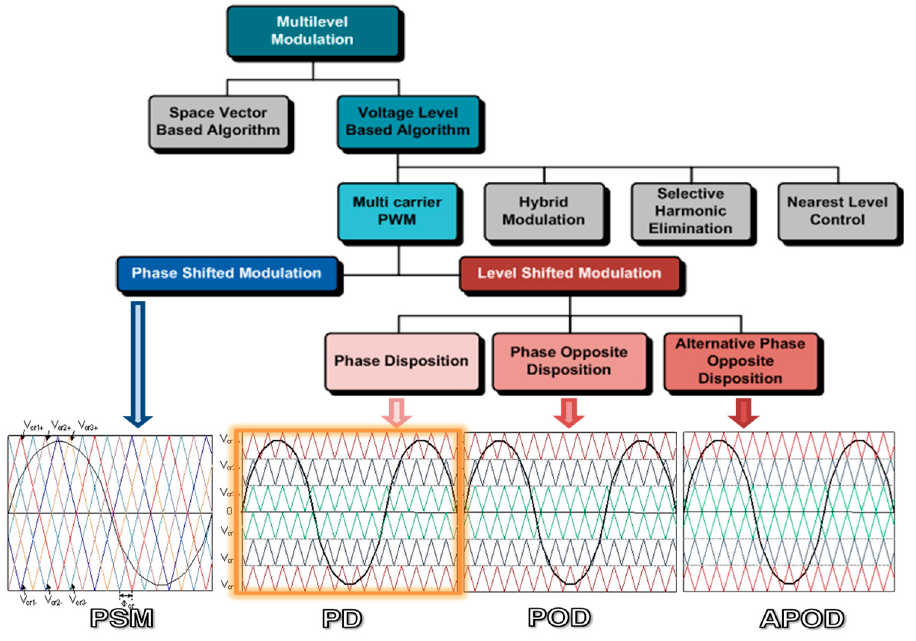
Figure 11. Classification of multi-carrier PWM technique.